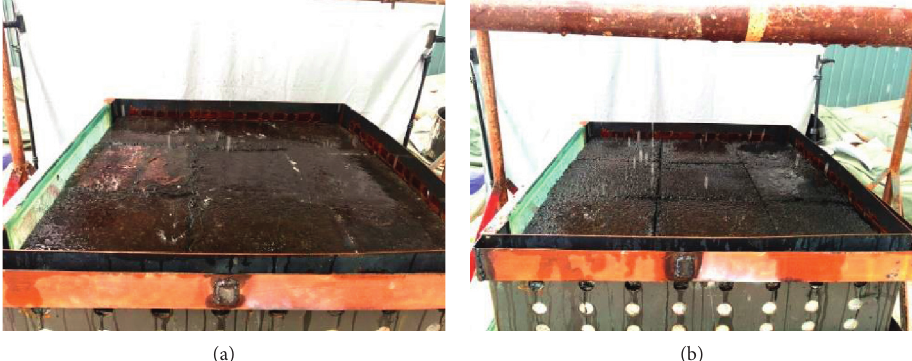
Figure 10: Rain intensity 4.6mm/min (when the rainfall lasted 60min). (a) Structural section type 1. (b) Structural section type